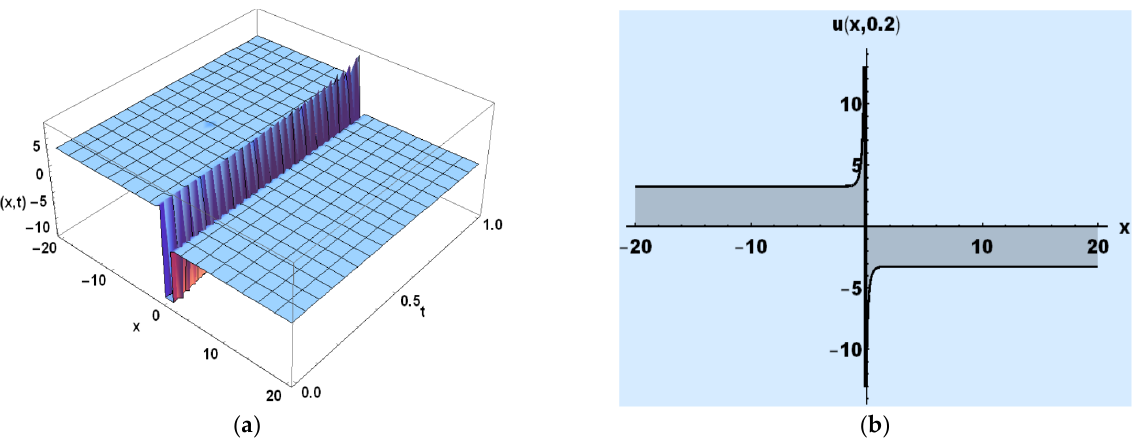
Figure 6. ( a , b ): Graphical analysis of Equation (26) for the values of the parameters A = 2,